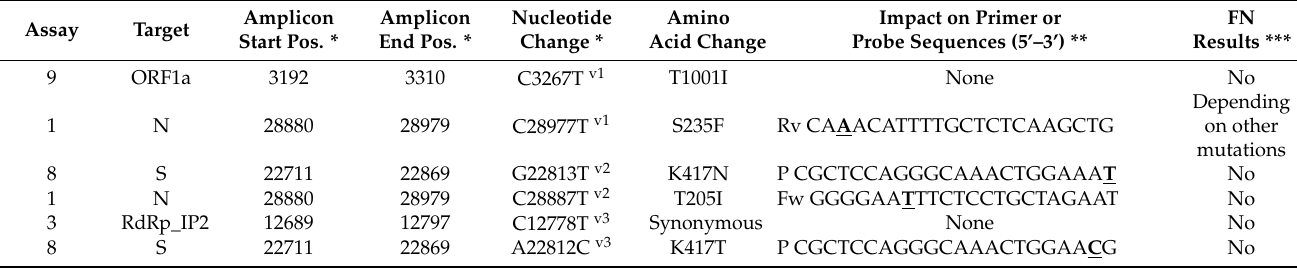
Table 4. Presence of severe acute respiratory syndrome coronavirus 2 (SARS-CoV-2) variants’ mutations in the sequence amplified by the evaluated primers and probe